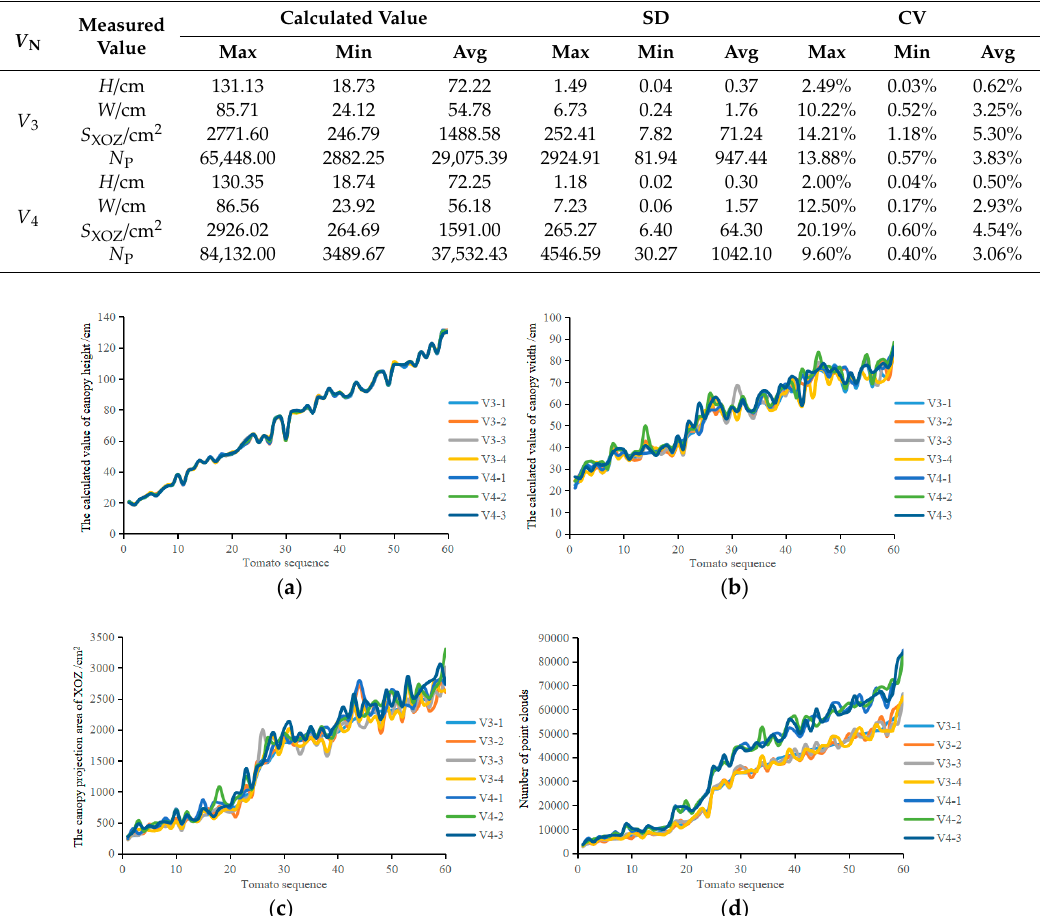
Figure 10. Canopy morphological parameters of GTPs: ( a ) canopy height H ; ( b ) canopy maximum width W ; ( c ) canopy projected area S XOZ ; ( d ) canopy point cloud number N p .